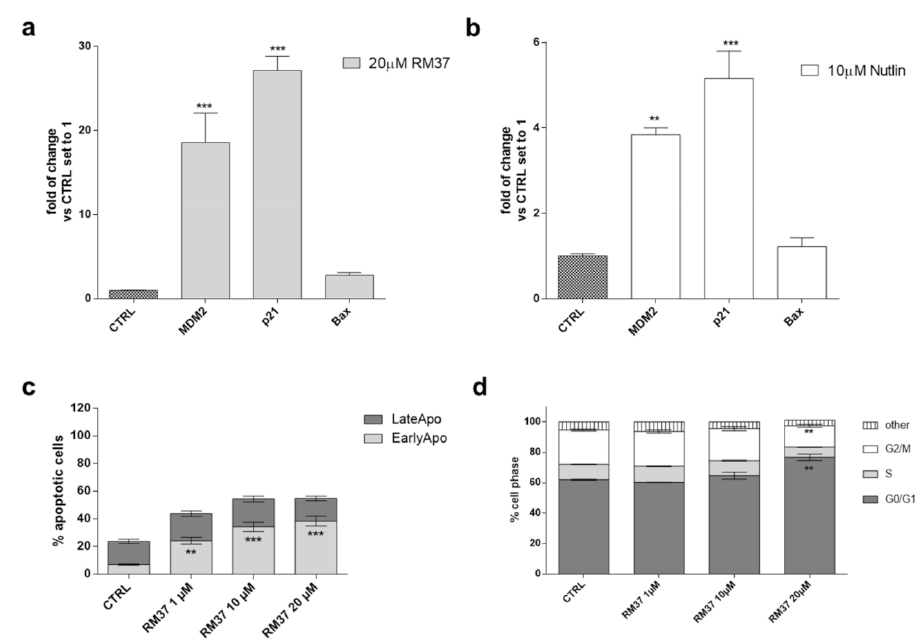
Figure 7. p53 functional reactivation in U343MG cells. ( a , b ) U343MG cells were challenged with 20 µ M RM37 or 10 µ M Nutlin-3a for 24 h. Relative mRNA quantification of p53 target genes (Bax, p21, and MDM2) was performed by real-time RT-PCR, as described in the Methods section. Data are expressed as fold of change versus control cells, set to 1. ( b,c ) U343MG cells were treated with DMSO (CTRL) or different concentrations of RM37 (1–20 µ M) for 48 h. In the end, the number of apoptotic cells ( c ) and cell cycle progression ( d ) were evaluated. Data are mean values ± SEM of three different experiments. ** p < 0.01; *** p < 0.001 versus respective